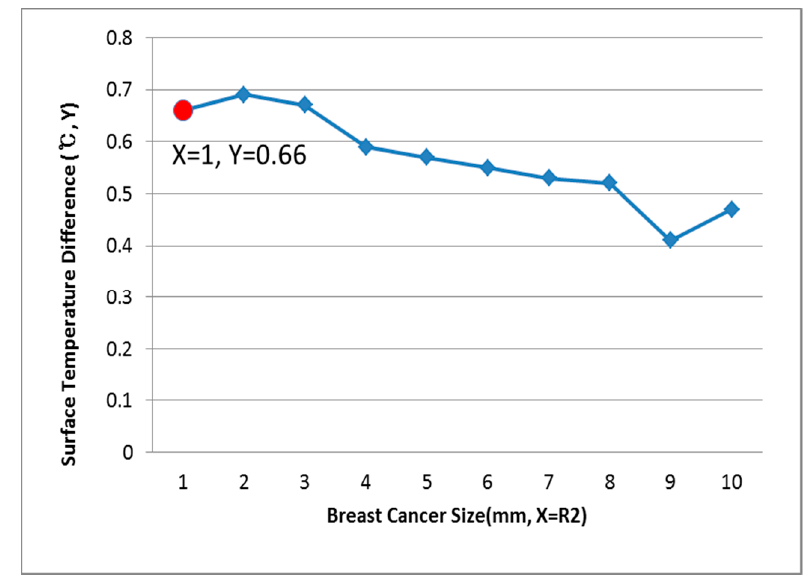
Figure 9. Surface temperature difference for R1 of 60 mm (X = 10, Y = 0).